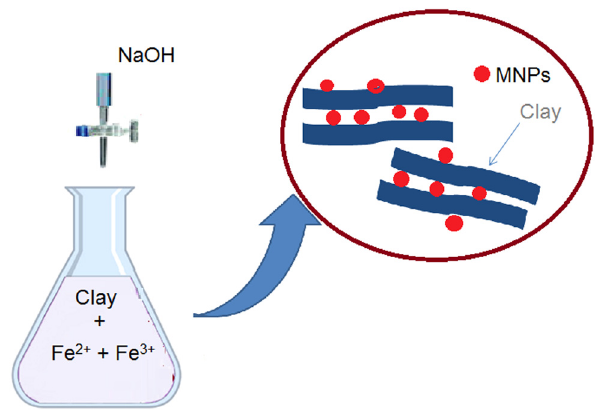
a ff ect the synthesis procedure and variables. Table 1 shows the clay minerals, speci fi c procedures, and synthesis parameters of various MICNCs. In general, there are two main synthesis procedures, co - precipita - tion and the intercalation of MNPs into a clay structure. The co - precipitation method is based on the chemical reaction used to produce magnetic nanoparticles in aqueous clay mineral dispersions, so the nucleation and growth of nanoparticles occur in situ in an aqueous dispersion of clay minerals, as described in Figure 2. The synthesis of nanocomposites by co - precipitation involves mixing clay mineral with MNP precursors under alkaline OH and/or NaOH condition to form a sol – gel system. NH 4 are commonly used to create the alkaline condition, which directly produces the precipitate of the composite [ 14,33,34 ] . The interaction between MNPs produced from clay minerals in a sol – gel system can be intensi fi ed using several methods, such as heating in a re fl ux system or microwave - irradiation. As the precipitate is created, drying or calcination can be conducted, which in fl uences the iron oxide phase and magnetization properties through various processes. Synthesis using Slovakian bentonite has shown that a higher drying temperature ( 85° ) successfully O phase with a magnetization of produces the γ - Fe 2 3 35 – 42 emu/g, while at a lower temperature ( 20°C ) , iron oxide presents in the oxo - hydroxide phase ( goethite ) and has a low magnetization ( 8 – 15 emu/g ) . The combination of co - precipitation and oxidation can also be conducted to fi nd a homogeneous MNP phase [ 18,38 ] . Instead of using iron salt as a precursor, an aqueous oxidation using NaNO 3 as an oxidant has been used to form Fe O nanoparticles 3 4 ( Fe O NPs ) . The homogeneous phase of iron oxide can be 3 4 obtained by conducting precipitation and oxidation under fl ow and the use of ultrasound - irradiation for the N 2 intensi fi cation. T a